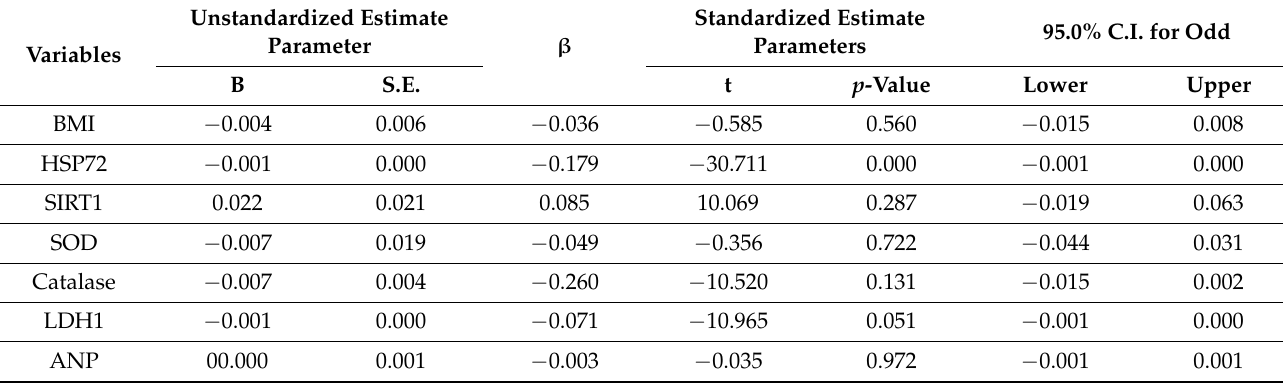
Table 3. Multiple linear regression analysis using biologically important variables as independent variables and CIMT as the dependent